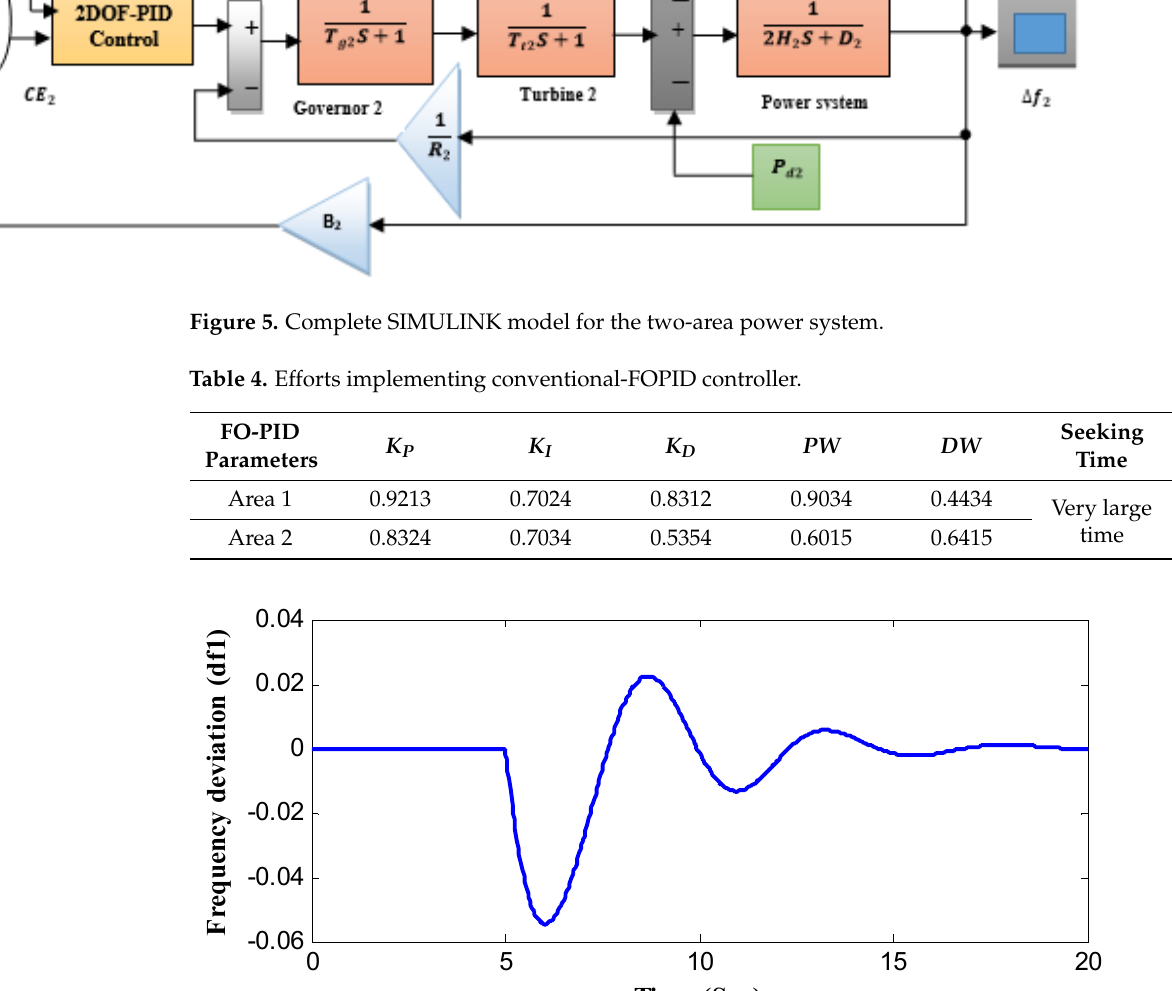
Table 4. Efforts implementing conventional-FOPID controller.